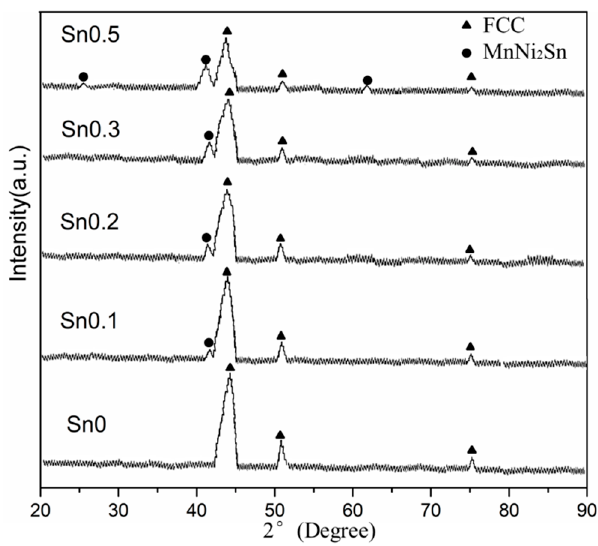
Figure 3. XRD patterns of CoCrFeNiMnSn x HEA coatings.